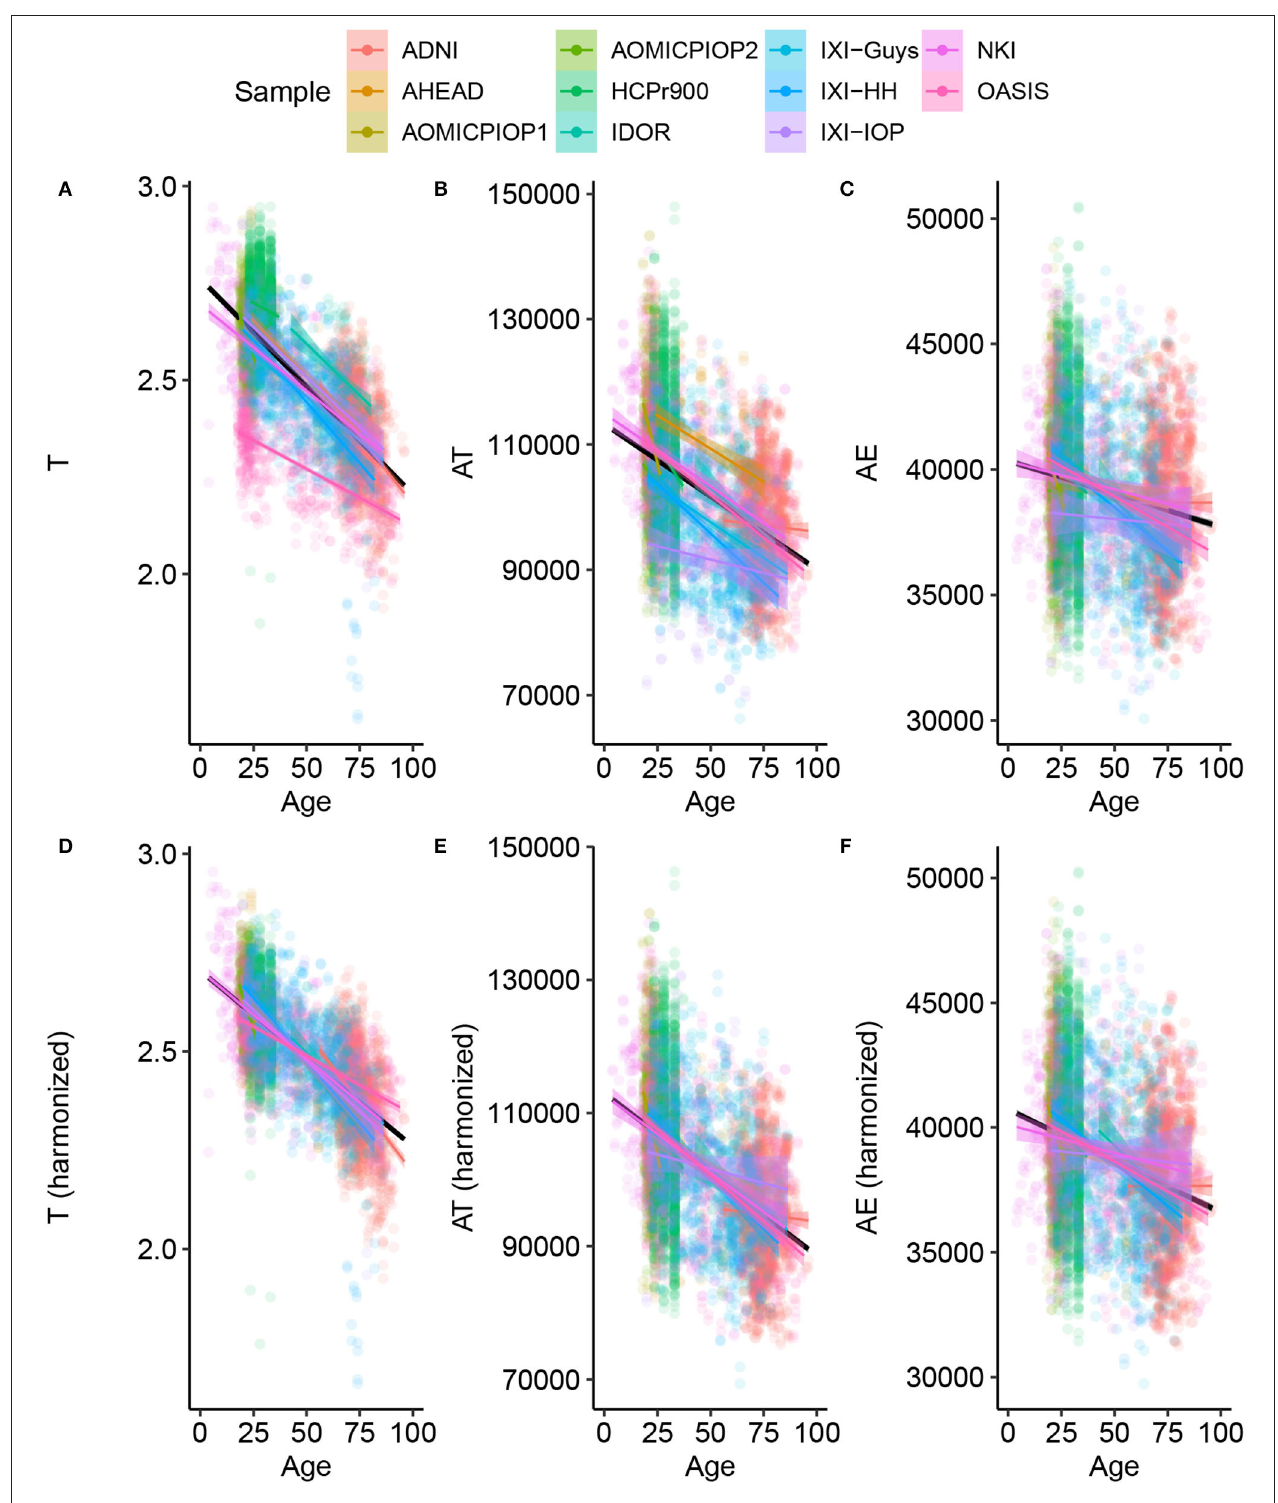
FIGURE 1 | Basic morphological variables through age for Healthy Controls (A–C) raw data (C–F) after harmonizing, removing the estimated residual from the Linear Mixed Model. This procedure results in the harmonized values of the novel morphological variables K, S, and I.